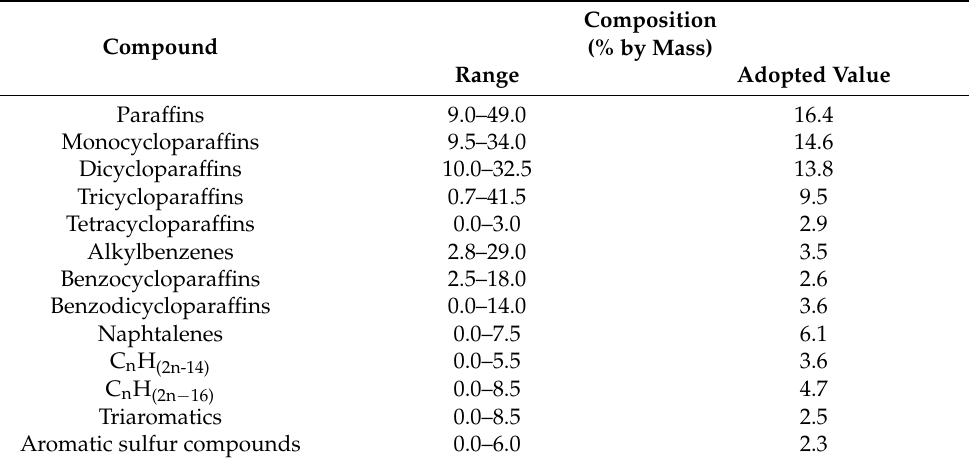
Table 2. Composition of commercial diesel oil: average values and reference for this study.